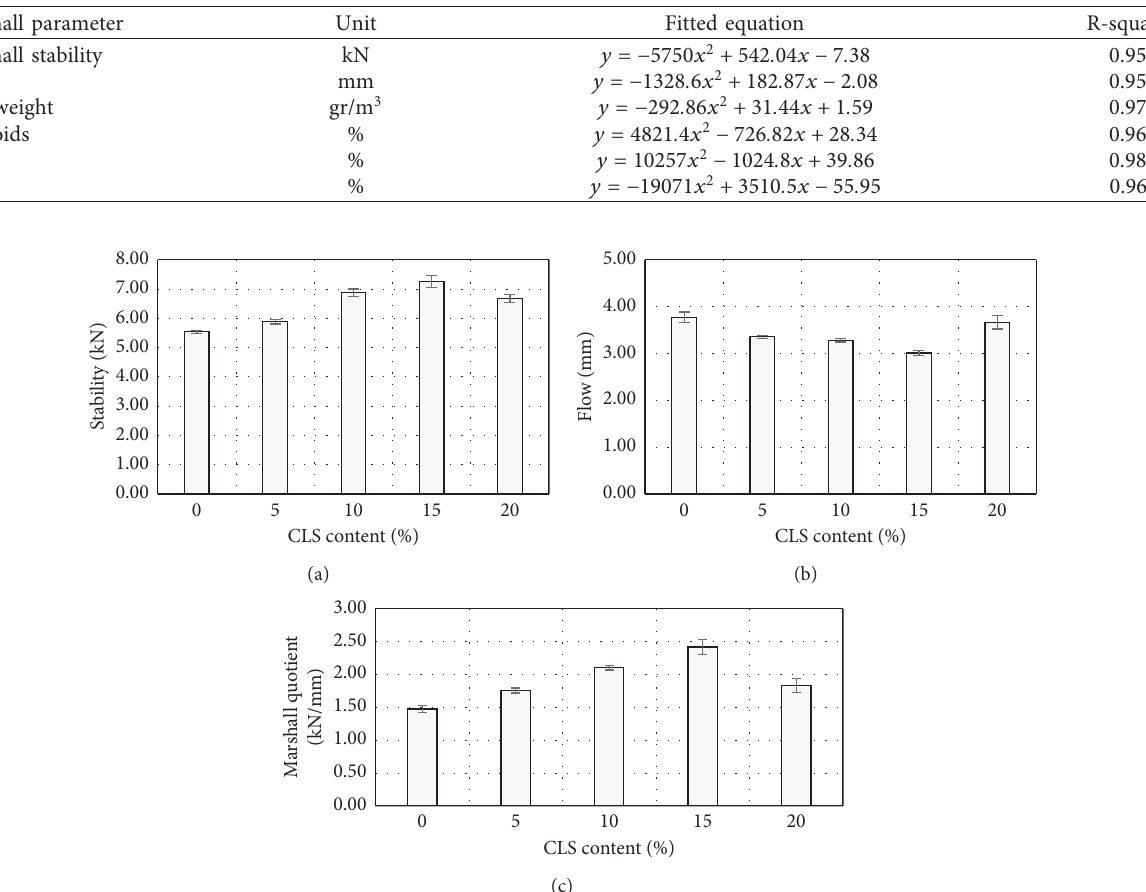
Table 8: Fitted equations of the Marshall design parameters.